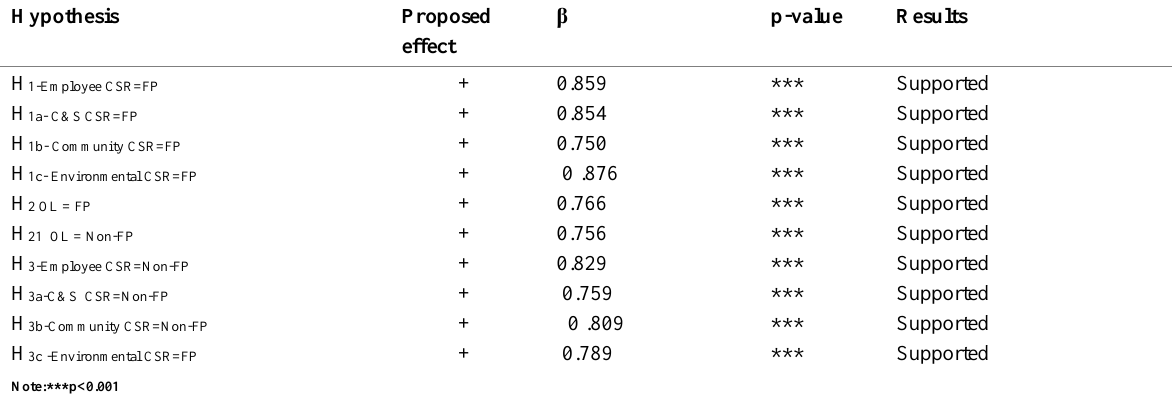
Table 5: Structural Model and Hypothesis Testing